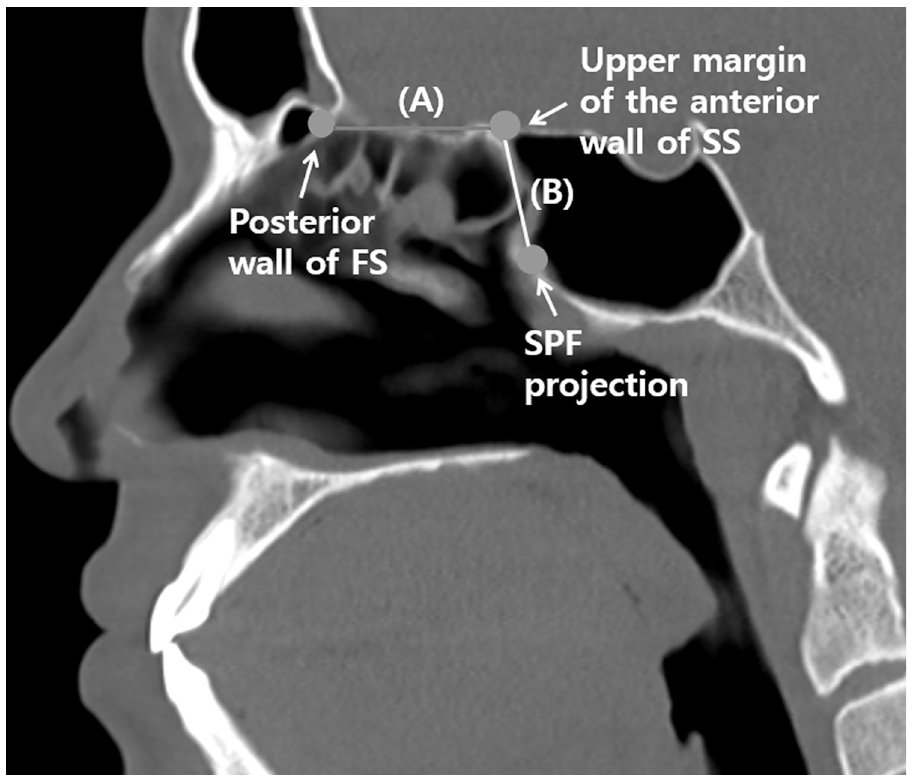
Fig 2. Measurement of the lengths of the skull base and anterior wall of the sphenoid sinus in the sagittal plane on PNS CT images. Distance from the posterior wall of the frontal sinus to the upper margin of the anterior wall of the sphenoid sinus (A). Distance from the upper margin of the anterior wall of the sphenoid sinus to the SPF projection (B). FS, frontal sinus; SB, skull base; SS, sphenoid sinus; SPF, sphenopalatine foramen.